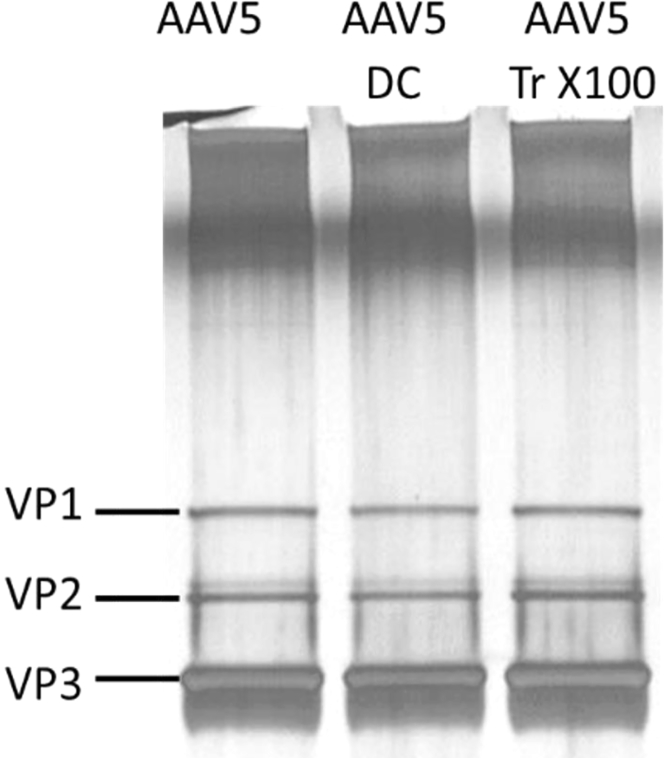
rAAV Capsid Protein Ratio and Thermostability following LPS Decontamination ProcedureDecontamination procedure doesn’t affect capsid protein ratio, as judged by silver-stained SDS-protein gel of AAV5.